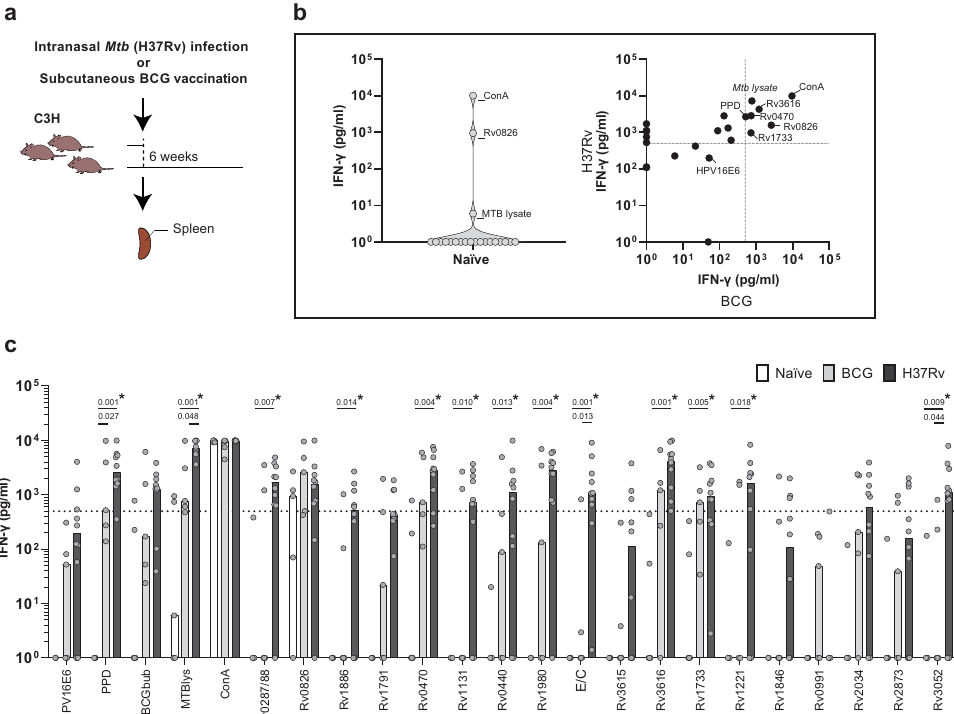
Fig. 2 IVE-TB antigen-speci fi c responses after Mtb infection and BCG vaccination in C3HeB/FeJ (C3H) mice. a C3HeB/FeJ mice were either challenged intranasally with H37Rv-Mtb strain (10 5 CFU) (10 mice), vaccinated subcutaneously with BCG (5 mice) or left untreated (5 mice). After 6 weeks, splenocytes were harvested and stimulated per mouse for 6 days with a set of eighteen Mtb antigens or positive controls (ConA, PPD, bead disrupted BCG (BCG bub) and Mtb lysate), or negative control (HPV16E6 recombinant protein). The IFN- γ concentrations detected in the unstimulated samples were subtracted from the stimulated samples for each condition within each mouse. b IFN- γ production after antigen stimulation in splenocytes from naïve unimmunized mice (left panel), and BCG immunised versus Mtb infected mice (right panel). Dots display the median IFN- γ production. The (Rv) codes of the antigens are indicated if the median IFN- γ production exceeded 500 pg/ml in both BCG immunised and Mtb infected mice. The horizontal dotted line indicates the cut-off at 500 pg/ml, which is twice the median IFN- γ production found in response to the negative control in BCG immunised and Mtb infected mice (right panel). c IFN- γ responses against Mtb antigens in splenocytes from naïve, BCG immunised and Mtb infected mice are shown. Dots represent a single mouse (10 mice in the Mtb infected group and 5 mice in the naïve and BCG immunised group in total) and bars indicate the median IFN- γ response of each group. The Mtb challenged and BCG immunised groups were compared to the naïve group using the Kruskal – Wallis test and a p -value < 0.05 was considered signi fi cant. Asterisk marks differences that remained signi fi cant after multiple test correction ( q -value < 0.1, i.e., FDR-adjusted p - values of Mann – Whitney